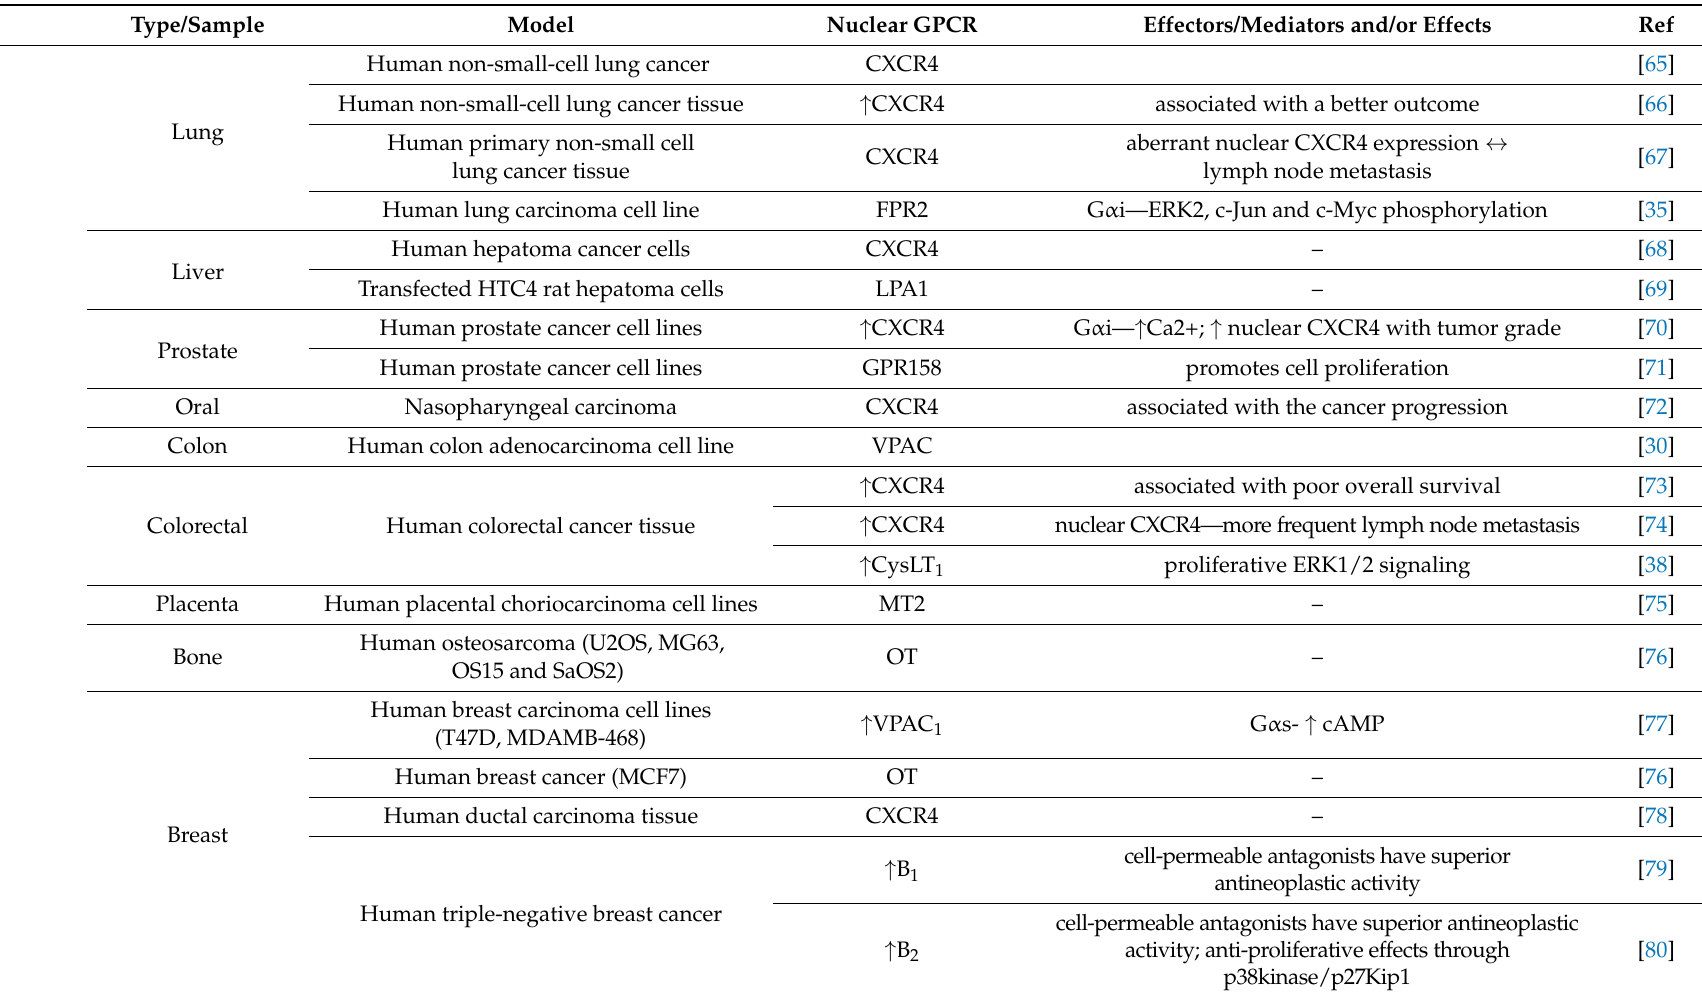
Table 1. Nuclear GPCRs occurrence in non-communicable